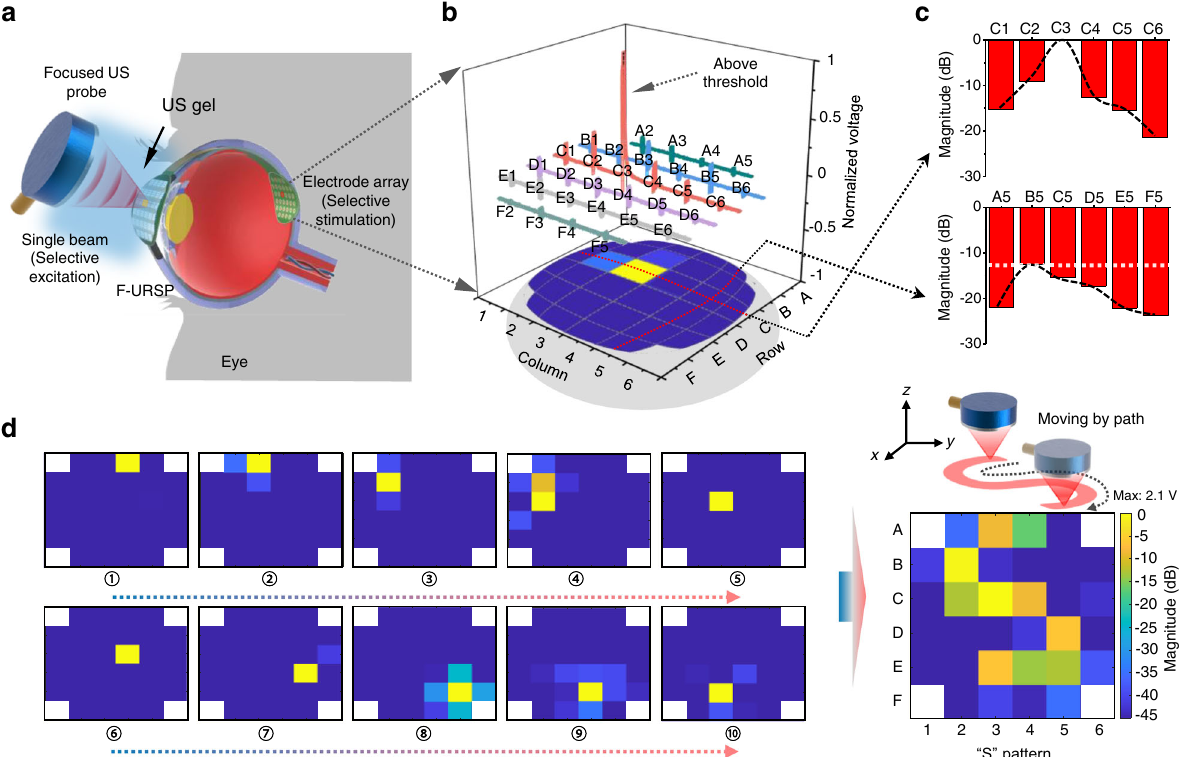
Fig. 4 Recognition function of the F-URSP induced by a focused transducer. a Schematic diagram showing one working model of the F-URSP, in which a focused US probe was used for selective excitation of the piezo-array. b Under the excitation of a single focused probe, the output voltage magnitude of each element in the array. c Line pro fi le data showing the signal-to-noise ratio of the output voltage magnitude for two typical positions-one on a row with excitation elements (horizontal line) and one off the excitation (vertical line)-showing unambiguous differences. d Voltage magnitude distribution imaging result by the F-URSP. The image was reconstructed in a time domain with the single probe moving following a programmable S-shaped path. The maximum output voltage is 2.1 V. The color bar indicates the magnitude distribution (20log V o ). Source data are provided as a Source data fi V max